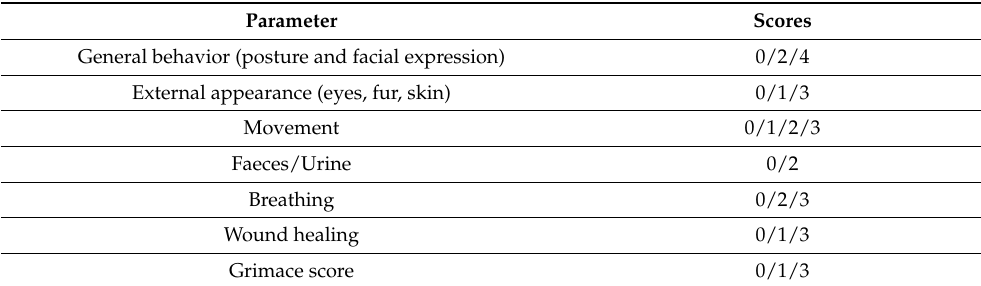
Table 1. Scoring system to monitor animal welfare [20,21].